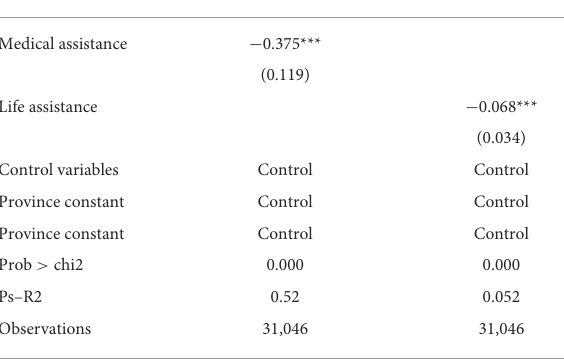
TABLE 3 Robustness test — substitution of the explained